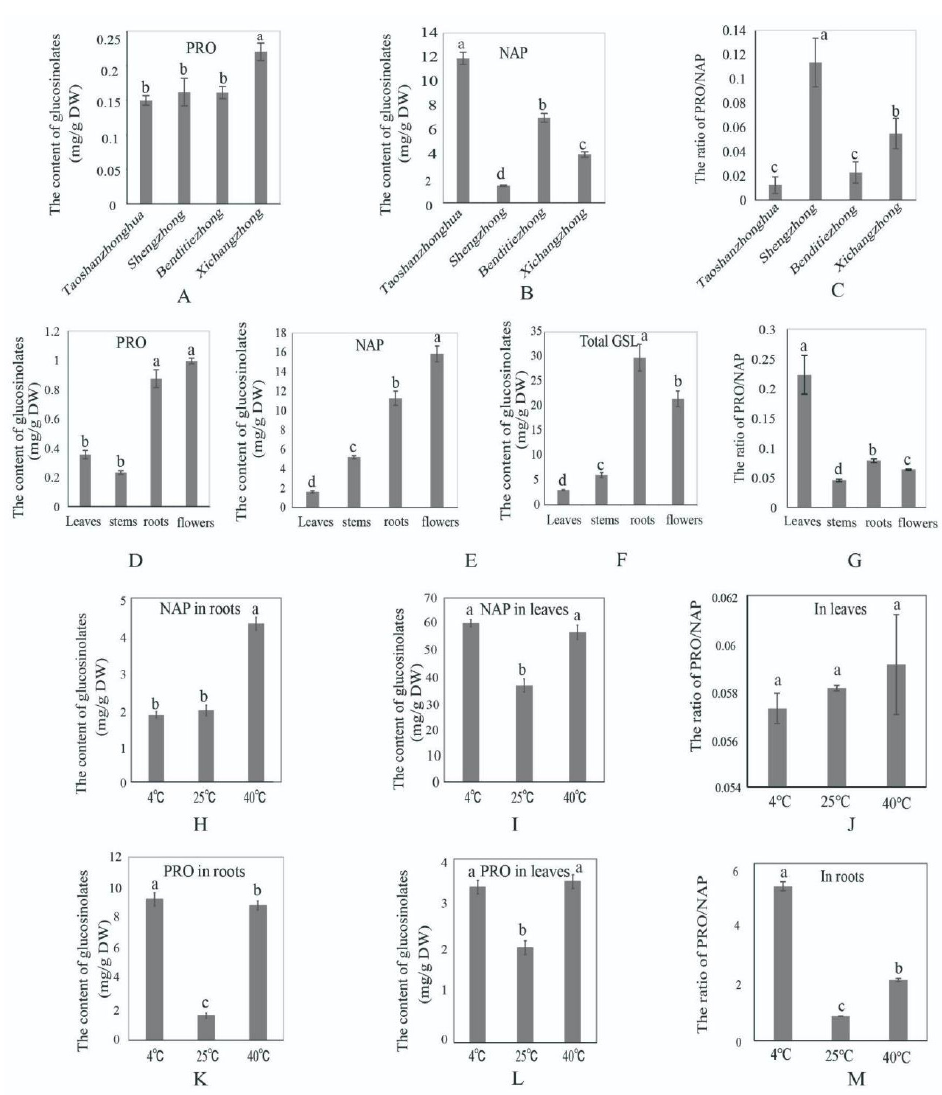
Figure 2. The determination of glucosinolates. ( A – C ) the content of PRO and NAP glucosinolates and the ratio of PRO/NAP in four different genotypes; ( D – G ) the content of PRO glucosinolate, NAP glucosinolate, total glucosinolates, and the ratio of PRO/NAP in four tissues; ( H , I ) the content of NAP glucosinolate in roots and in leaves after cold and heat stress; ( J ) the ratio of PRO/NAP in leaves after cold and heat stress; ( K , L ) the content of PRO glucosinolates in roots and in leaves after cold and heat stress; ( M ) the ratio of PRO/NAP in roots after cold and heat stress. Different letters (a, b, c, d) indicate statistically significant difference between samples (one-way ANOVA, Tukey’s test p<0.05)